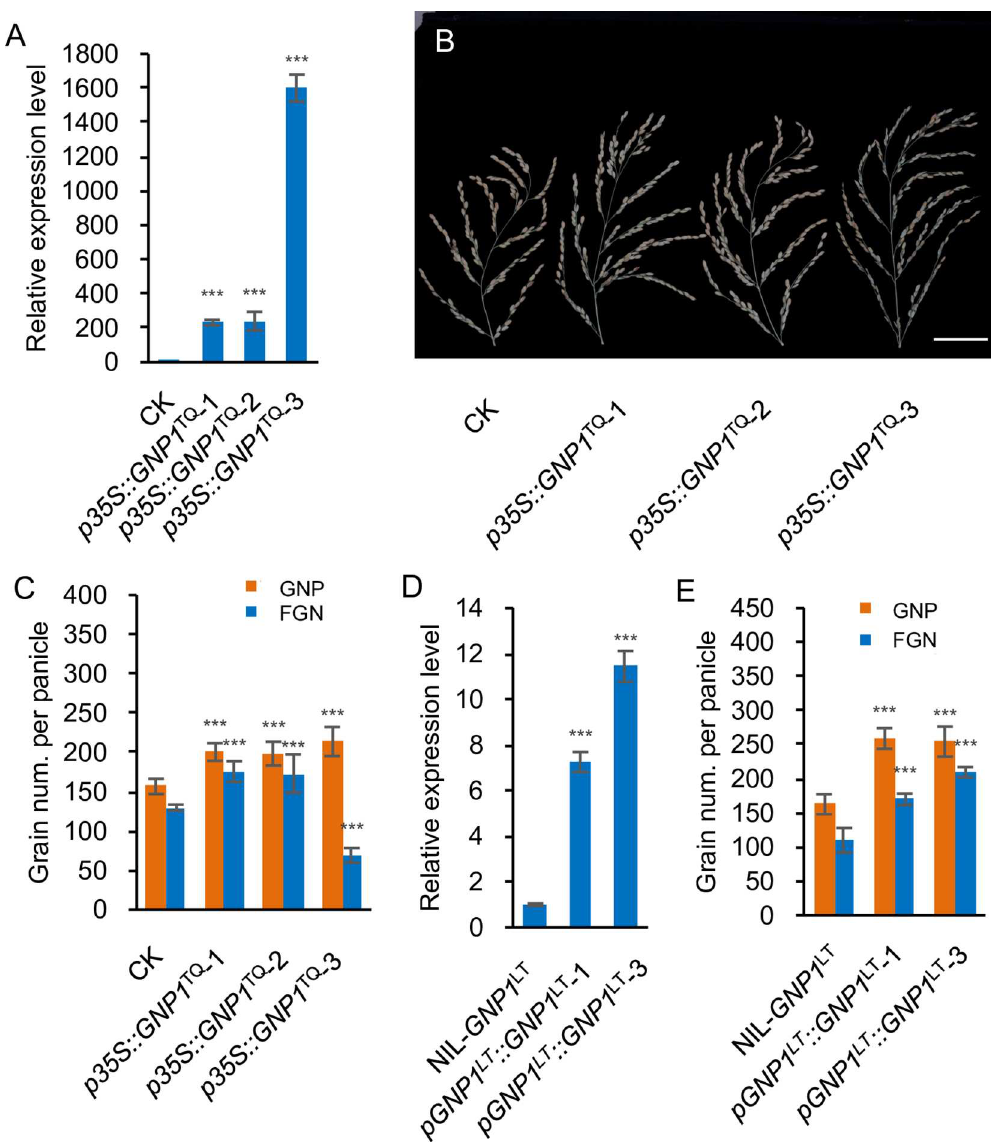
Fig 3. Effect of overexpression of GNP1 in transgenic rice lines. (A) Relative expression levels of GNP1 in the flag leaves of three independent GNP1 TQ overexpression lines and CK (transgenicnegative control). Values are means ± s.d. (n = 4). (B) Panicle morphology of three independent GNP1 TQ overexpression lines and CK. Scale bar, 5 cm. (C) Comparison of GNP and FGN between three independent GNP1 TQ overexpression lines and CK. Values are means ± s.d. (n = 10). (D) Relative expression levels of GNP1 in the flag leaves of two independent pGNP1 LT :: GNP1 LT overexpression lines and the recipient NIL- GNP1 LT . Values are means ± s.d. (n = 4). (E) Comparison of GNP and FGN between two independent pGNP1 LT :: GNP1 LT overexpression lines and the recipient NIL- GNP1 LT . Values are means ± s.d. (n = 10). Asterisks represent significant difference determined by Student’s t-test at p -value < 0.001 ( ***